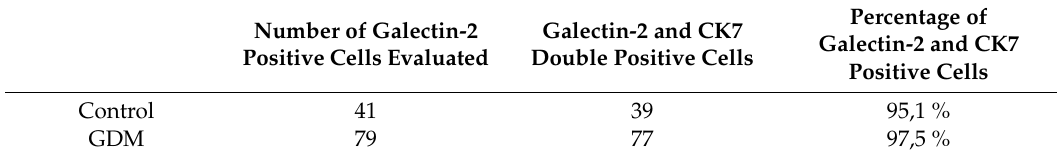
Table 1. Quantification of galectin-2 expressing